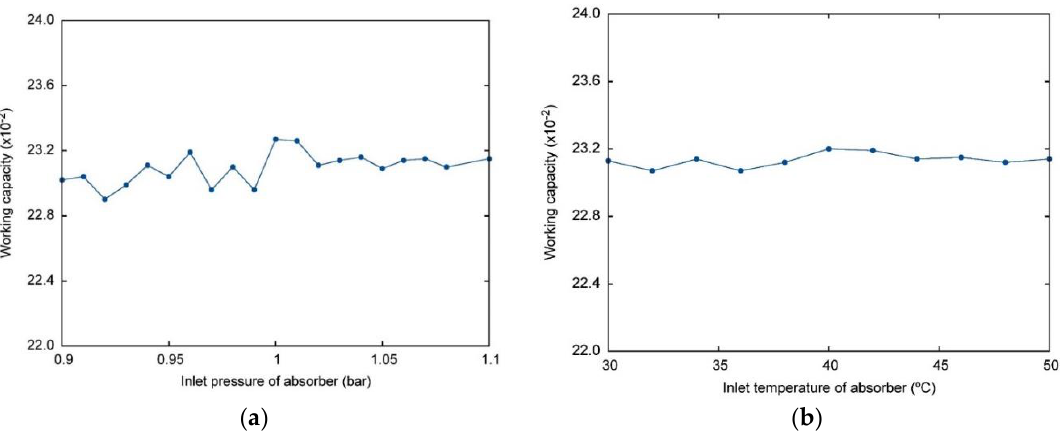
Figure 6. ( a ) Variation of working capacity versus inlet pressure of absorber. ( b ) Variation of working capacity versus inlet temperature of